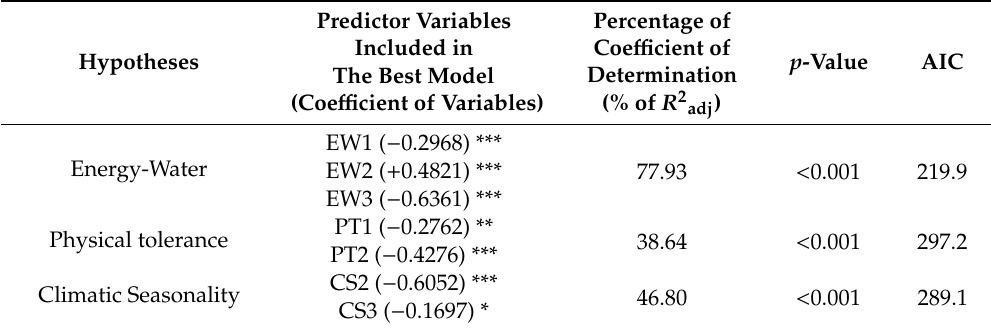
Table 1. Percentage of coe ffi cient of determination ( R 2 adj , %) by the generalized linear models (GLMs) between species richness of gymnosperms and predictor variables sets representing each hypothesis set. p -value is the significance value and AIC is the Akaike’s information criterion value of each model. Numbers in parentheses are the coe ffi cient of respective variables.